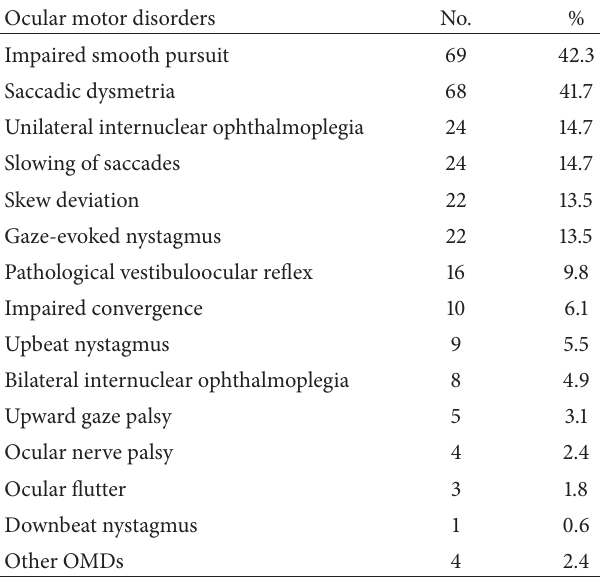
Table 2: Ocular motor disorders in 150 patients with definite multiple sclerosis and 13 patients with clinically isolated